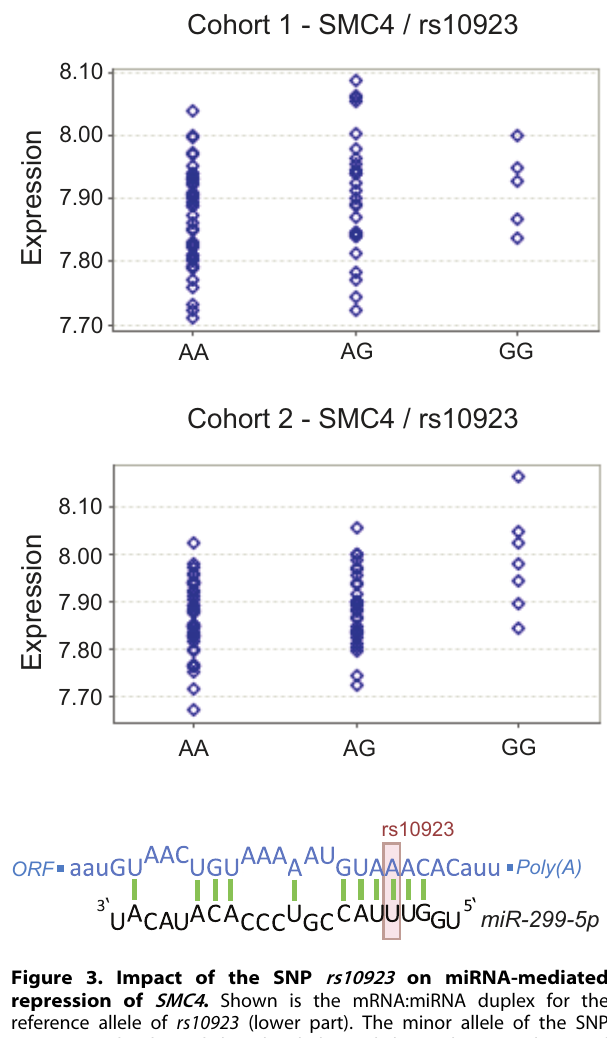
Figure 3. Impact of the SNP rs10923 on miRNA-mediated repression of SMC4 . Shown is the mRNA:miRNA duplex for the reference allele of rs10923 (lower part). The minor allele of the SNP (position adumbrated by the light red box) disrupts the seed complementary region. In the upper part of the figure, the expression pattern of SMC4 in lymphoblastoid cells is illustrated. The minor G allele of the polymorphism is significantly ( P combined v 5 : 9 : 10 { 4 ) linked to an increased abundance of SMC4 transcript. For the illustration of expression values Genevar output was adapted [89]. doi:10.1371/journal.pone.0036694.g003 PLoS ONE |